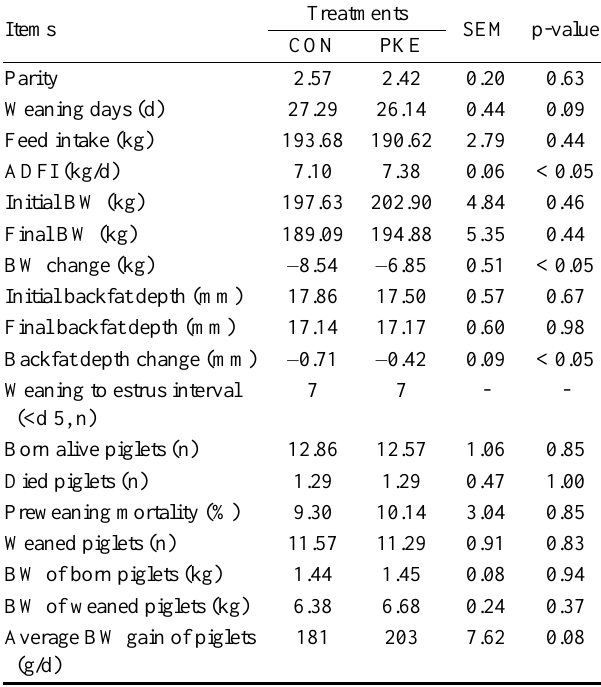
Table 2. Productive performance of lactating sows fed dietary treatments 1